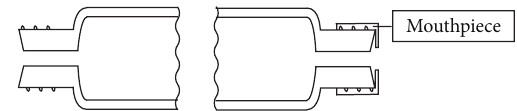
Figure 2: Sketch of the valveless gas sampling tube, ready for sam- pling; open-top cap screwed on as a mouthpiece.